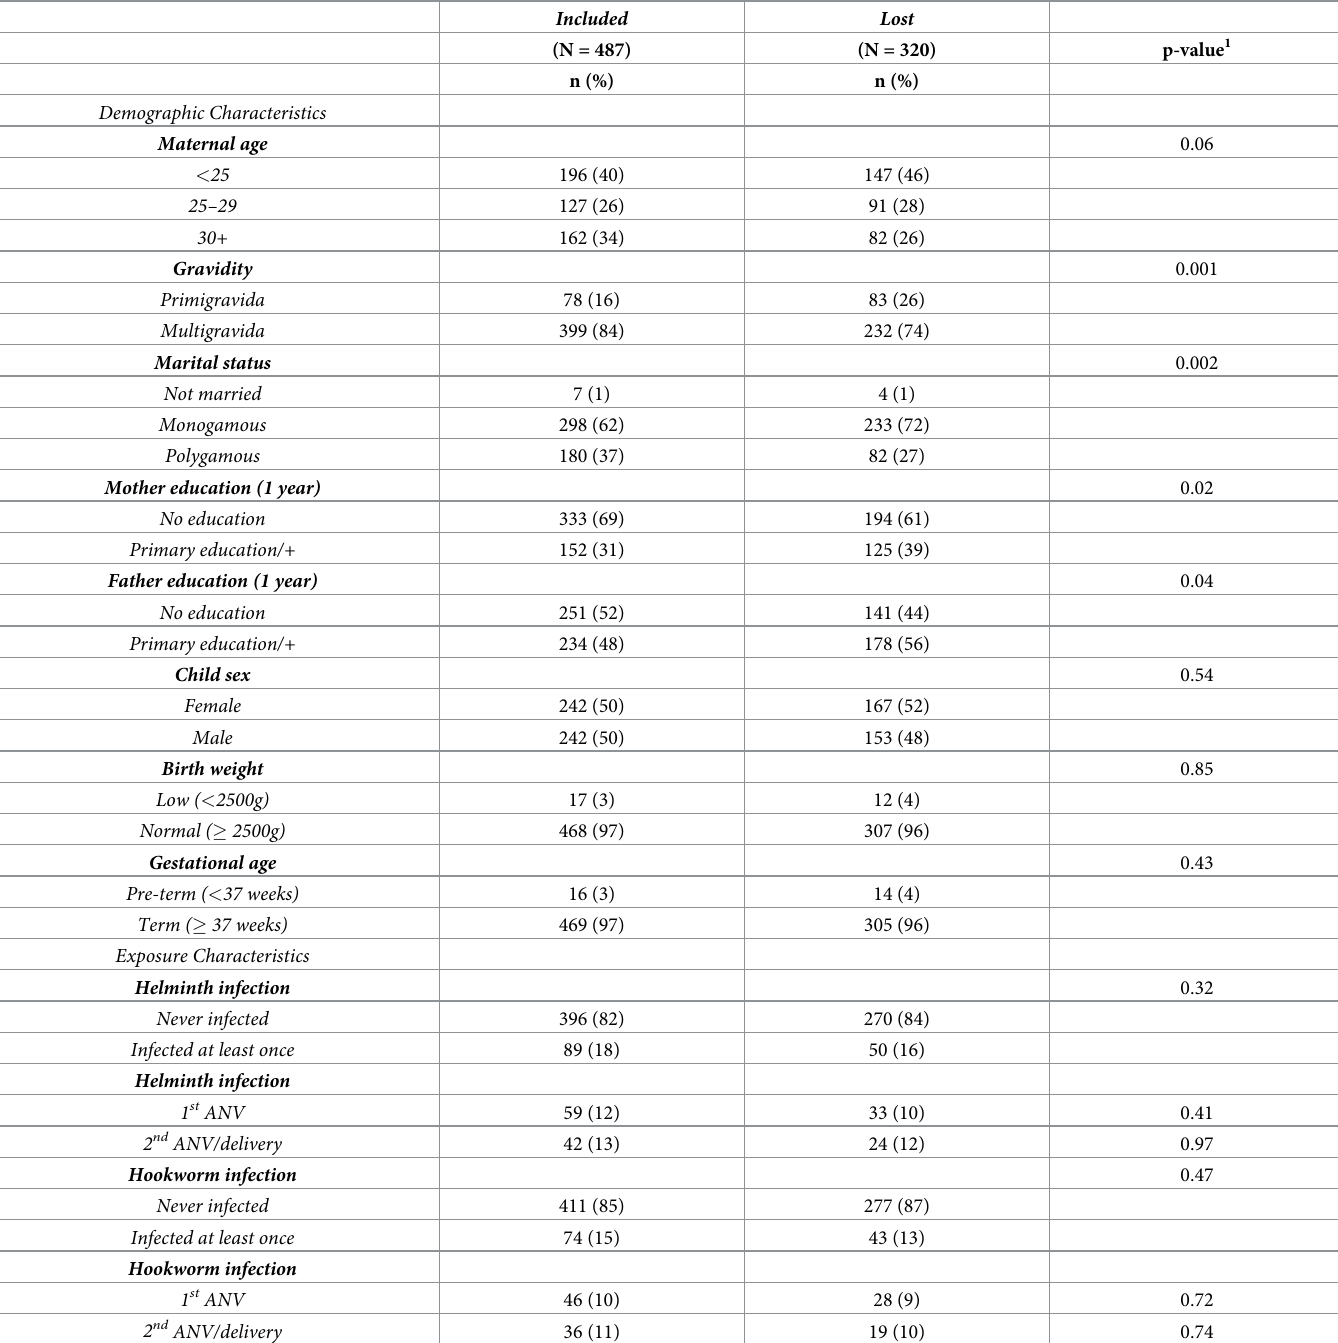
Table 1. Demographic and exposure characteristics of mothers and children included in analyses compared to those lost to follow-up. Included